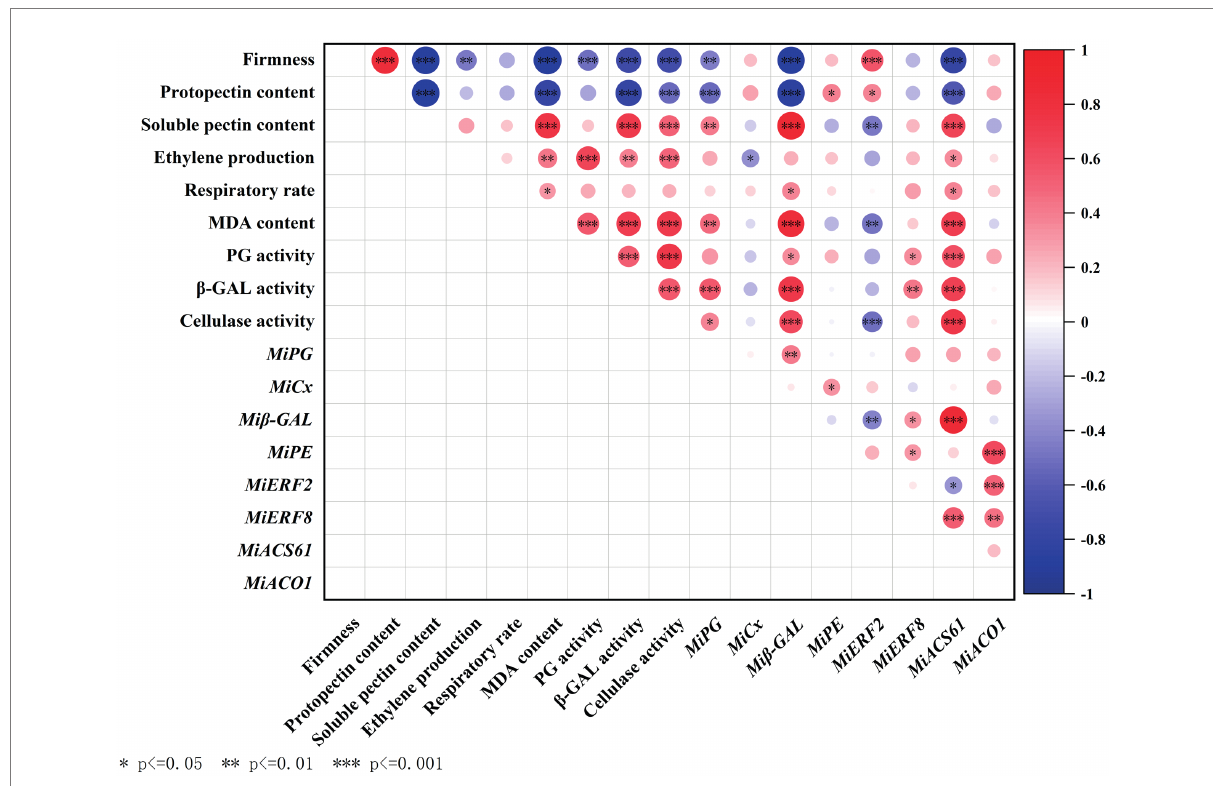
FIGURE 5 Correlation analysis between parameters including firmness, protopectin content, soluble pectin content, ethylene production, respiratory rate, MDA content, activities of PG, β -GAL and cellulase, and expressions of MiPG , Mi β -GAL , MiCX , MiPE , MiERF2 , MiERF8 , MiACO1 and MiACS6 . Asterisks indicate significant differences as determined by Duncan’s multiple range test (* p < 0.05, ** p < 0.01 and *** p <